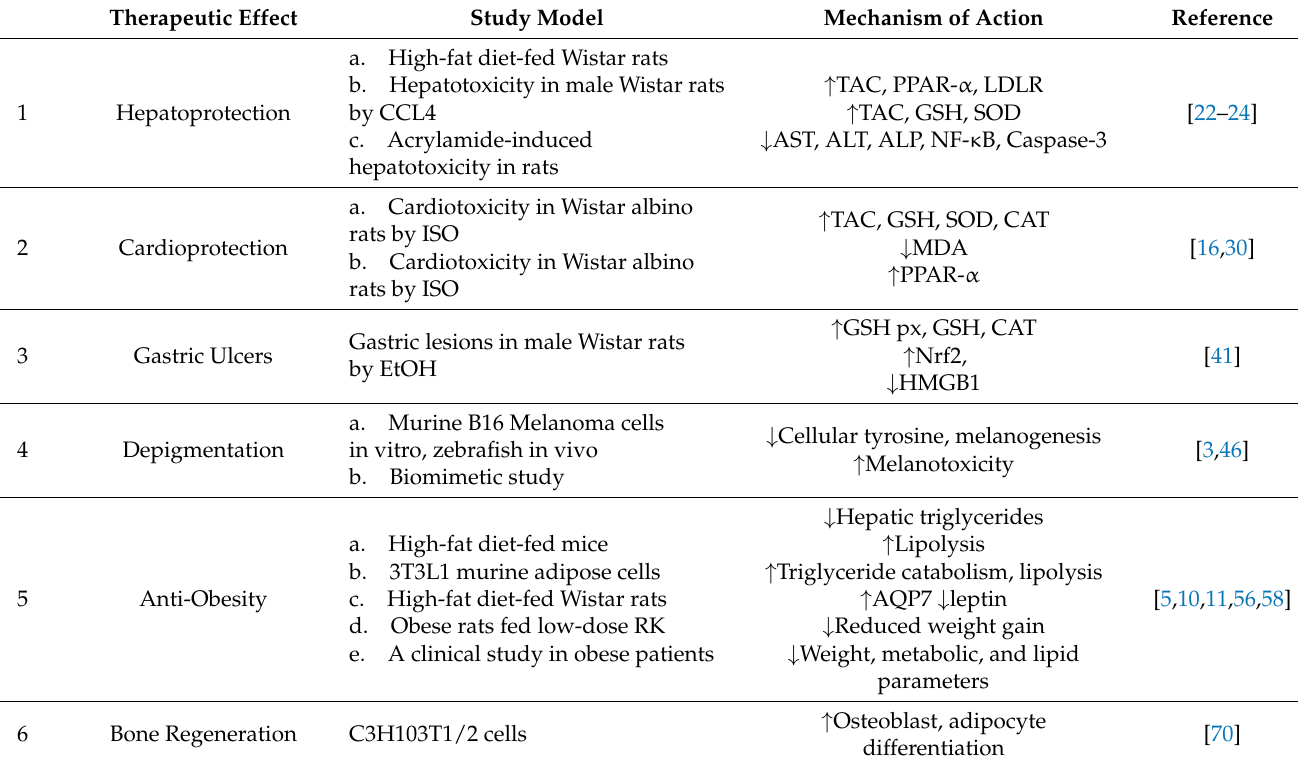
Table 2. Summary of therapeutic properties and mechanism of action of raspberry ketone (RK). Therapeutic Effect Study Model Mechanism of